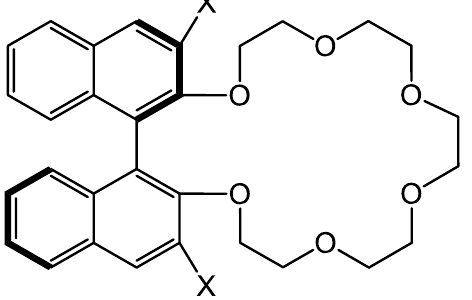
Figure 6. Structure of CSPs applied in Ref. [38] (X: Cl, Br, or I).